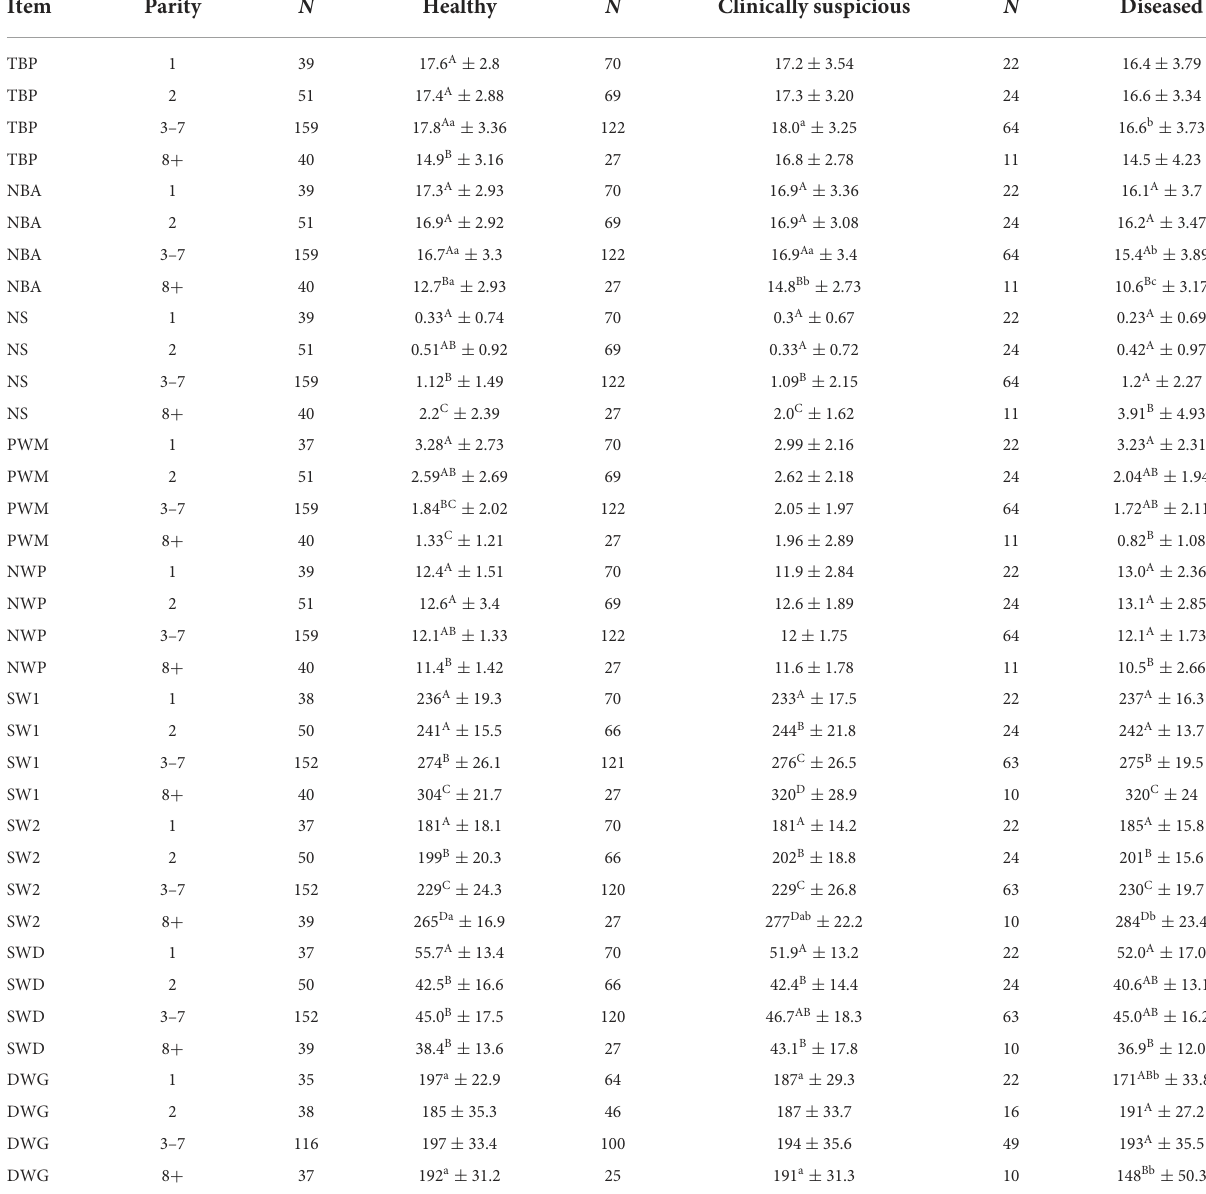
TABLE 7 Comparison of performance parameters between healthy, clinically suspicious and diseased sows of different